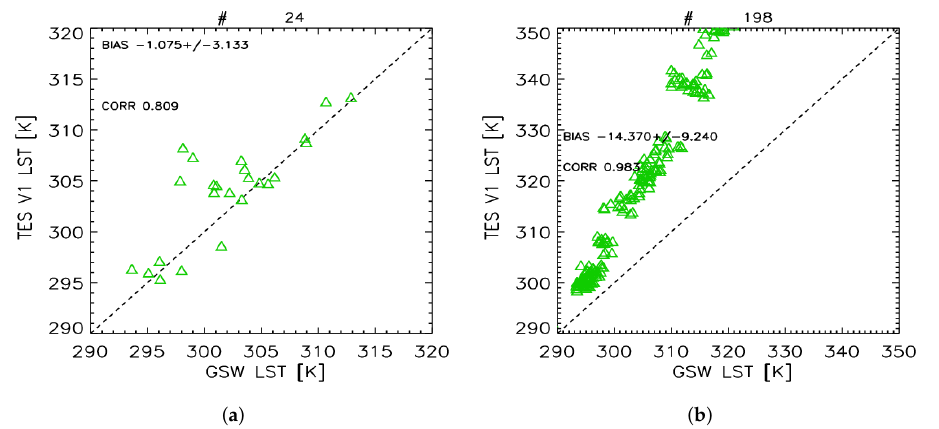
Figure 9. ( a ) LST retrieved with GSW vs. TES on 24 GANDART signatures (#24). ( b ) LST retrieved with GSW vs. TES over 198 TASI2DART signatures